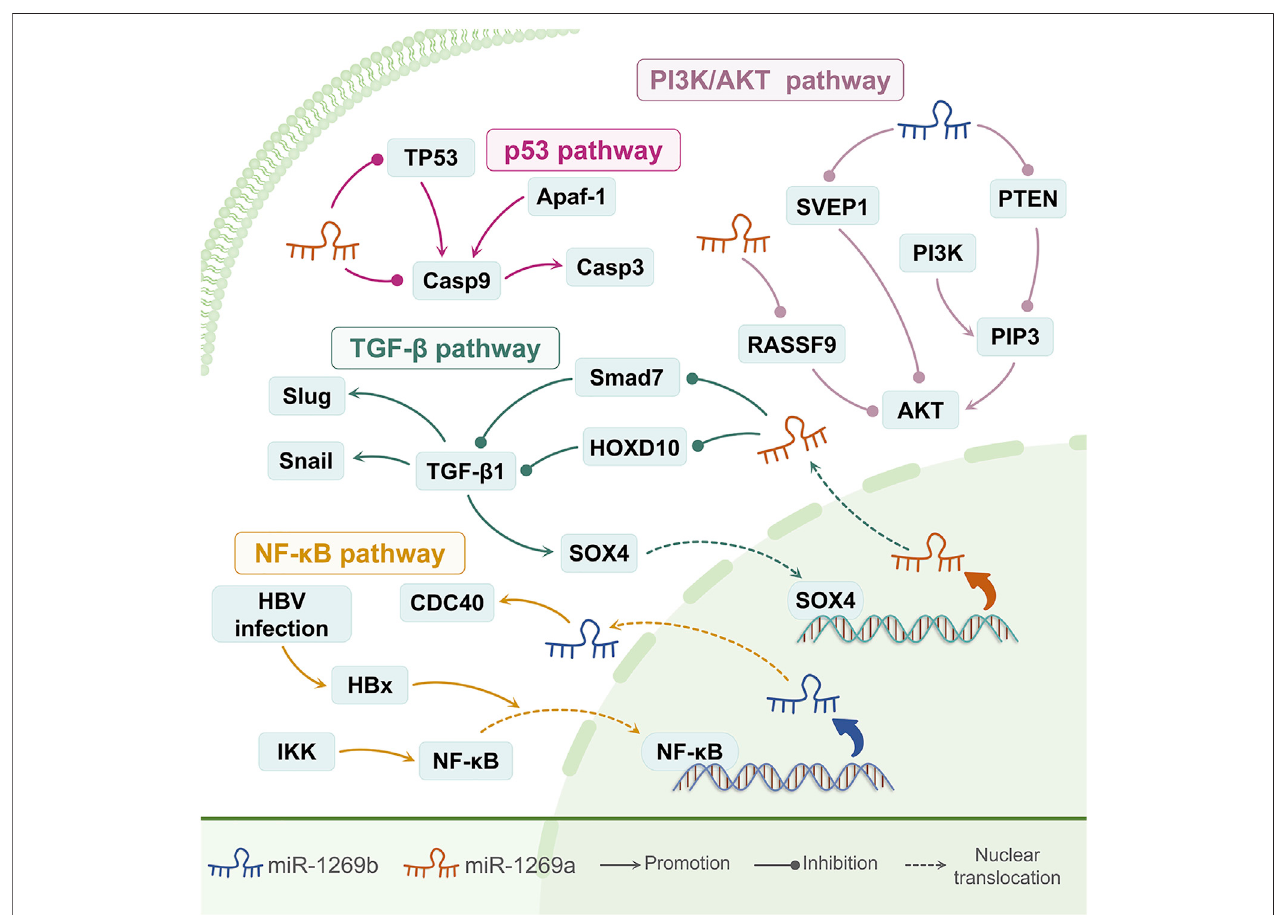
FIGURE 2 | The signaling pathways involved with miR-1269a and miR-1269b. A schematic illustration of the roles of miR-1269a and miR-1269b in multiple signaling pathways. miR-1269a caninhibitapoptosis byinhibiting TP53, thecoreofthe p53 signaling pathway, and Casp9, theinitiationfactor ofapoptosis. miR-1269a up-regulatesTGF- β signaling bysuppressingits antagonists Smad7andHOXD10.TGF- β ,inturn, up-regulatesmiR-1269a via SOX4toformapositivefeedbackloopin the TGF- β signaling pathway. miR-1269a also activates the PI3K/AKT signaling pathway by inhibiting RASSF9. miR-1269b participates in the activation of the PI3K/AKT signaling pathway by inhibiting SVEP1 and PTEN, and HBx promotes tumor progression by inducing miR-1269b to up-regulate CDC40 in an NF- κ B dependent manner.